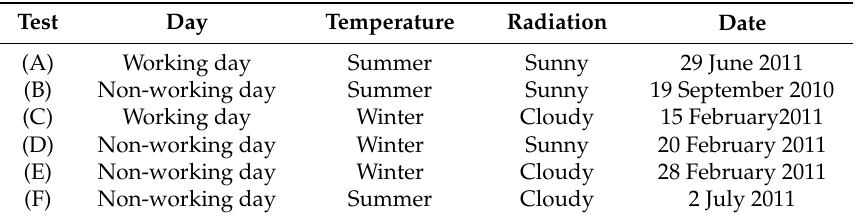
Table 10. Battery of tests performed.